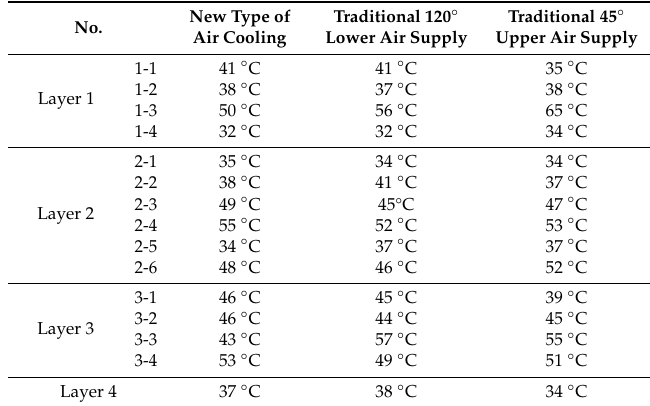
Table 2. Heat sources temperature of each layer in rack.